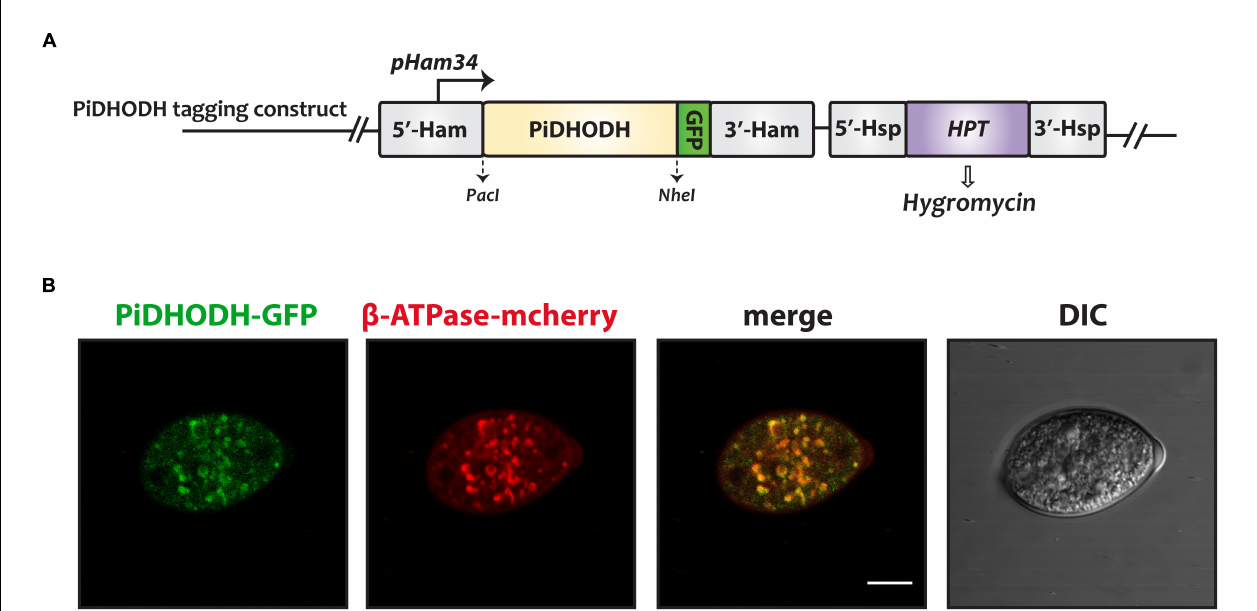
FIGURE 2 | The subcellular localization of P. infestans DHODH in sporangia. (A) The construct used to produce DHODH fused on the C-terminus to green fluorescent protein (GFP). (B) A sporangium doubly transformed with GFP-labeled PiDHODH (green), and with the mitochondrial marker, ATP synthase fused to mCherry (red) (Ah-Fong and Judelson, 2011) is shown. DIC, differential interference contrast. Scale bar: 10 µ m.